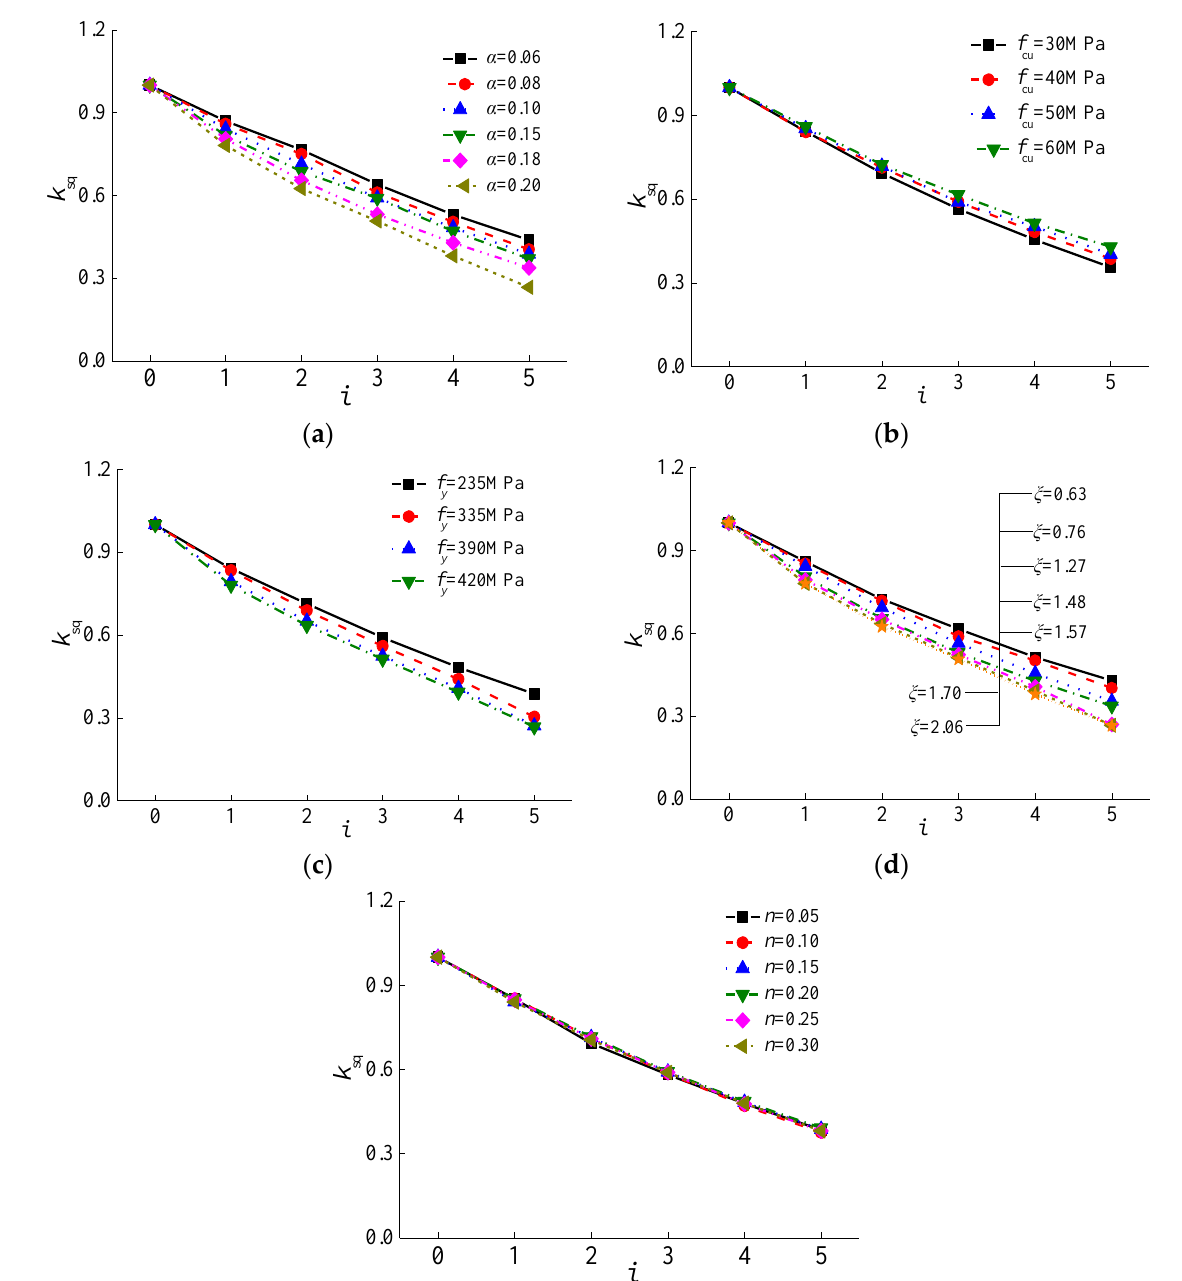
Figure 23. Effects of main parameters on reduction factor of horizontal bearing capacity. ( a ) Steel ratio; ( b ) Compressive strength of concrete; ( c ) Yield strength of steel tube; ( d ) Confinement coefficient; ( e ) Axial compression ratio.